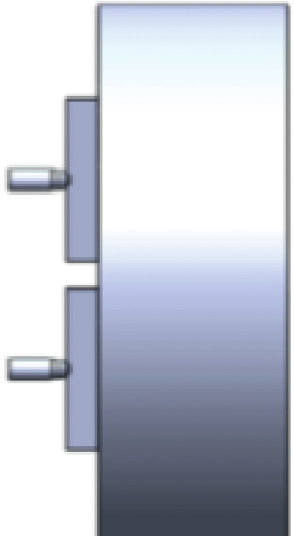
Figure 14: 3D model with different